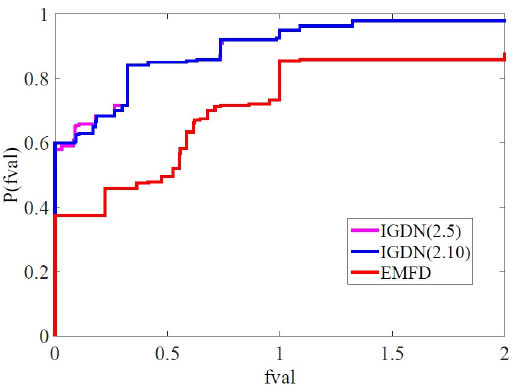
Figure 2. Performance profile of IGDN versus EMFD [8] with respect to fval .